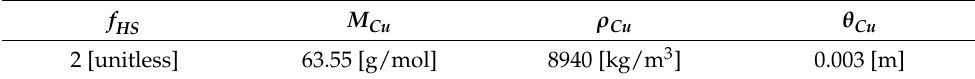
Table 4. Values for the calculation of